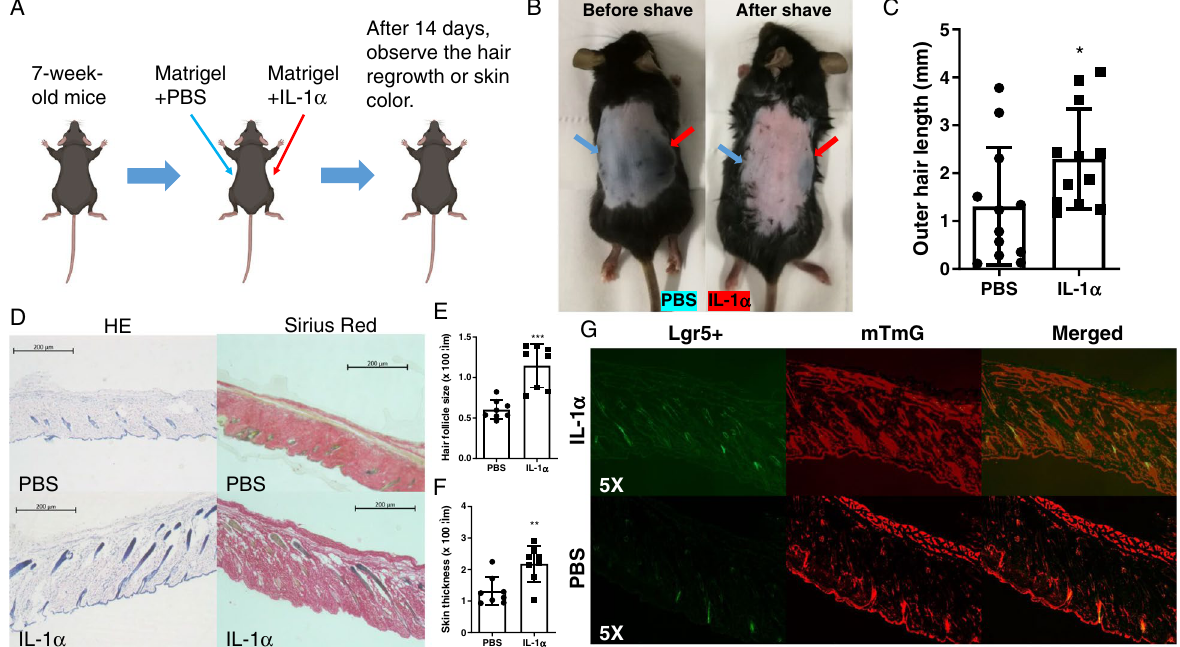
Fig. 7 IL-1α stimulated hair follicle conversion from telogen to anagen phase and induced Lgr5 HFSCs proliferation in 7W mice. A Experimental steps. B Representative photos of mice on the 14th day after treatment. Blue arrows direct the control (PBS) area, and red arrows direct the treatment (IL-1α) area. C IL-1α increased outer hair length (PBS vs IL-1α, 1.304 and Sirius Red staining from the same mouse. E IL-1α increased HFs size. (PBS vs IL-1α, 0.6032 skin thickness (PBS vs IL-1α, 1.316 *** P <